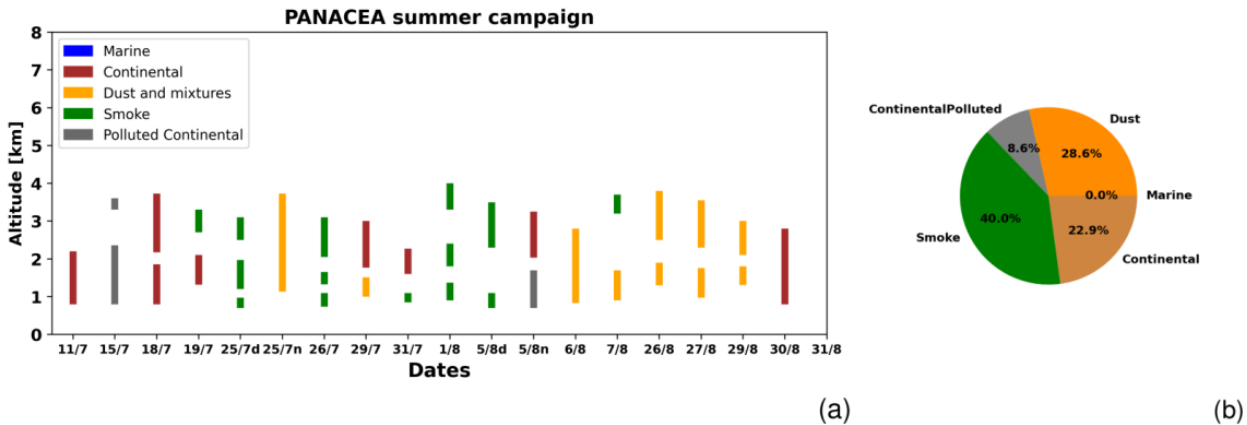
Figure 7. ( a ) Geometrical boundaries of the aerosol layers identified and ( b ) percentages of the typed aerosol layers during the summer campaign from the daytime and nighttime Raman measurements, over Thessaloniki.